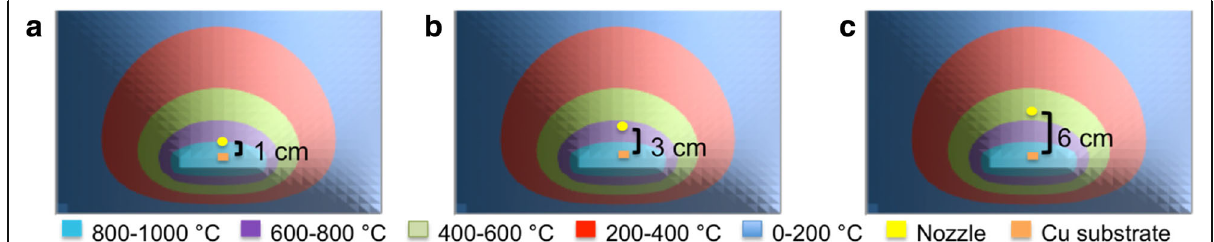
Fig. 2 Heat distribution (cross-view) in the reaction chamber and the location of nozzle from the substrate with a distance of a 1 cm, b 2 cm, and, c 6 cm